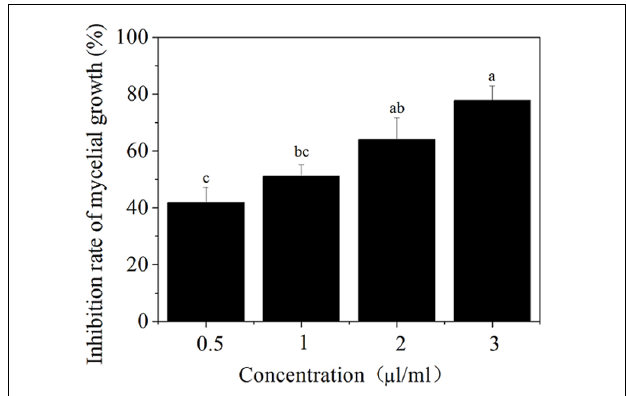
FIGURE 1 | Effects of Solidago canadensis L. essential oil (SCLEO) vapor at different concentration on mycelial growth of Botrytis cinerea. Vertical bars represent the standard error of the means. Bars labeled with the same letter are not significantly different.